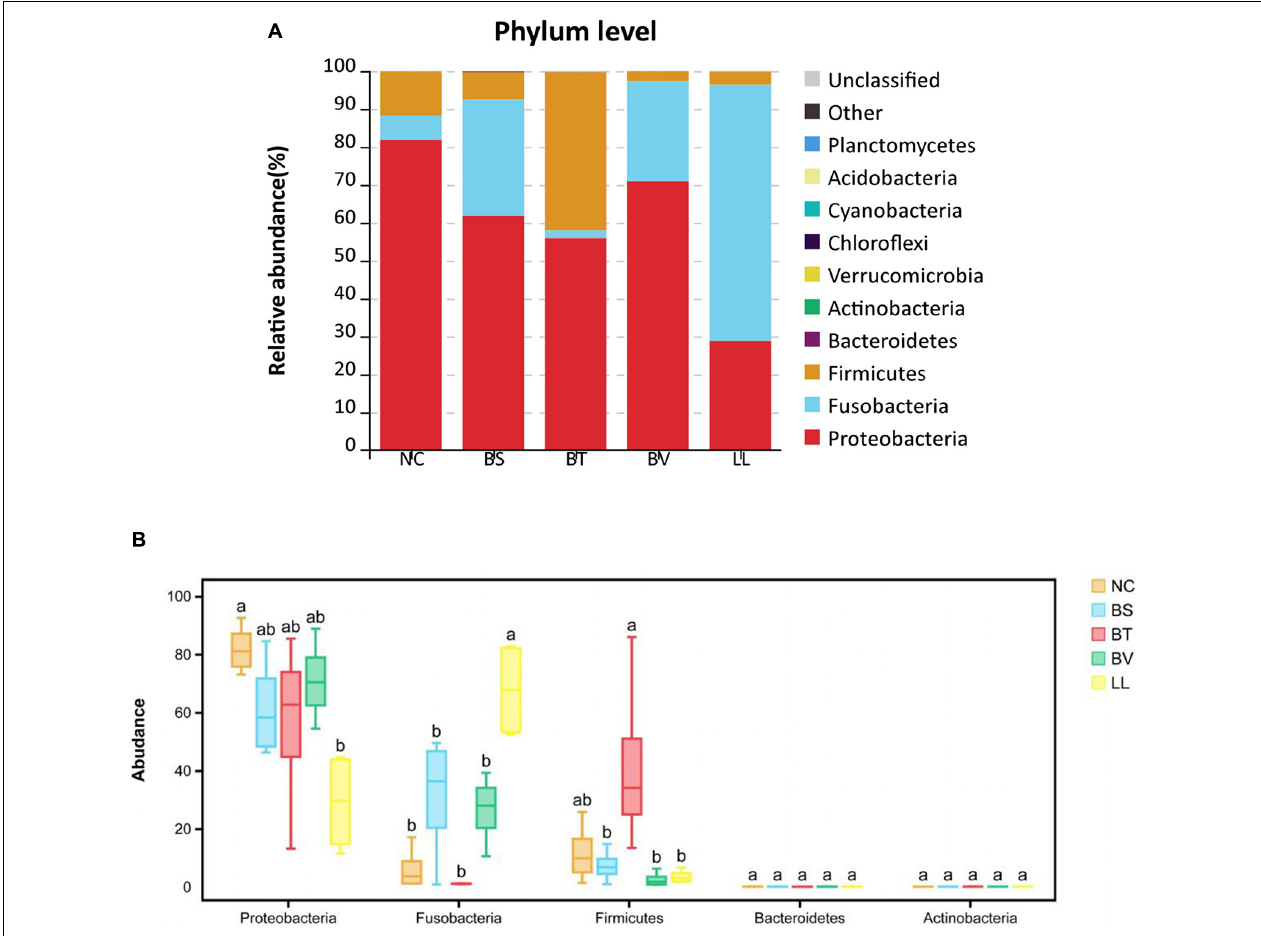
FIGURE 6 | The relative abundance of major bacterial phyla in (A) barplot and (B) boxplot. Bars with different letters were significantly different ( p < 0.05). NC, control diet; BS, control diet containing 1 × 10 7 CFU/g of Bacillus siamensis ; BT, control diet containing 1 × 10 7 CFU/g of Bacillus tequilensis ; BV, control diet containing 1 × 10 7 CFU/g of Bacillus velezensis ; and LL, control diet containing 1 × 10 7 CFU/g of Lactococcus lactis .